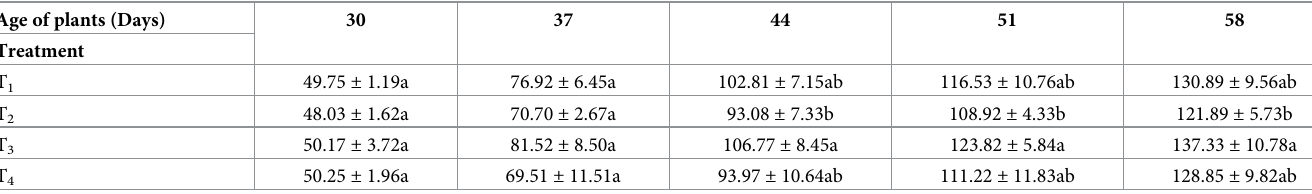
The data shown are the mean values of 4 replicates of planting pots per treatment (each planting pot contains 9 plants). Different letters indicate significant differences at P < 0.05, using LSD’s Multiple Range Test.